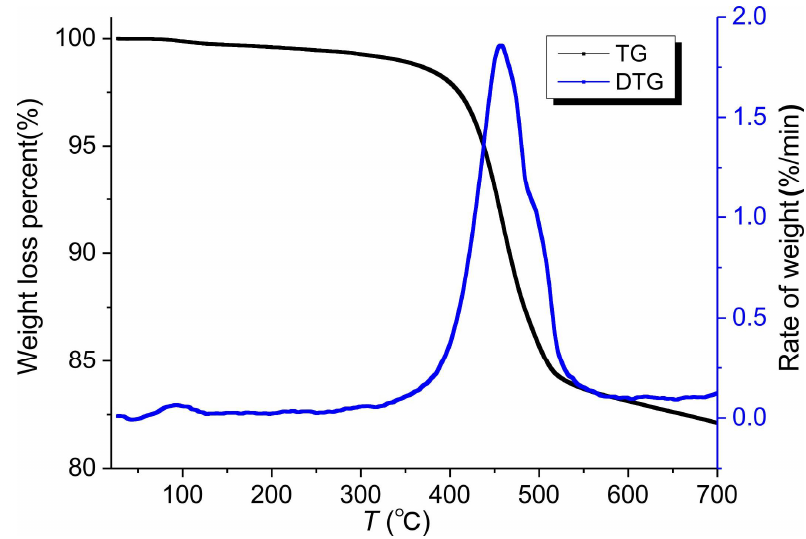
Figure 1. TG/DTG curve of Fushun oil shale.